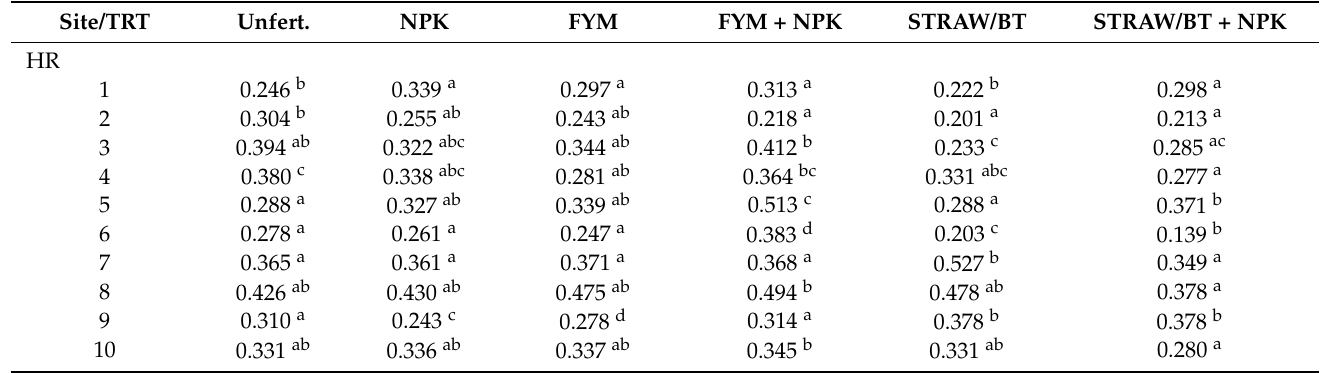
Table 6. Humification rate (HR) and humification index (HI) in soil at the individual experimental